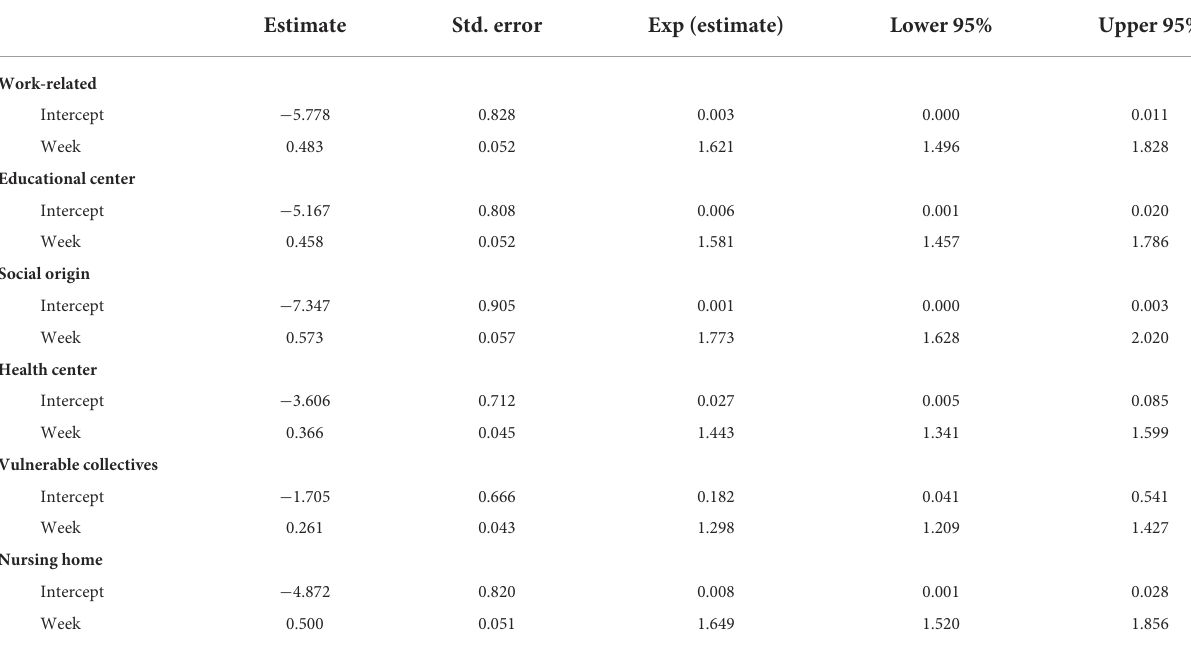
TABLE 3 Main statistics of the monotonic effect model, i.e., a Bayesian negative binomial function with monotonic effects applied to each outbreak origin. Estimate Std. error Exp